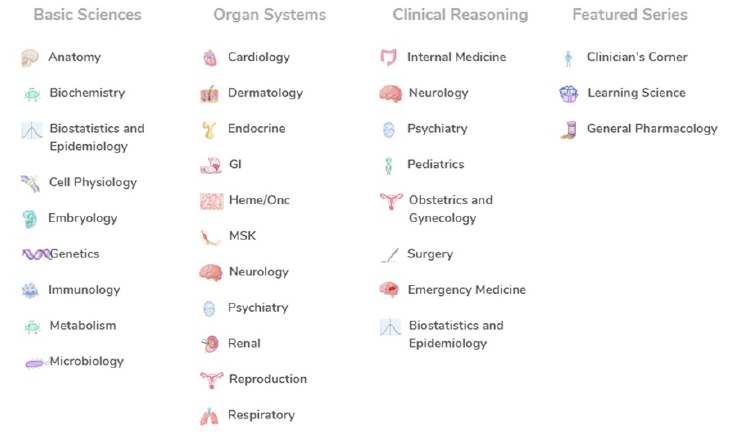
Used with permission; 2 October, 2019;